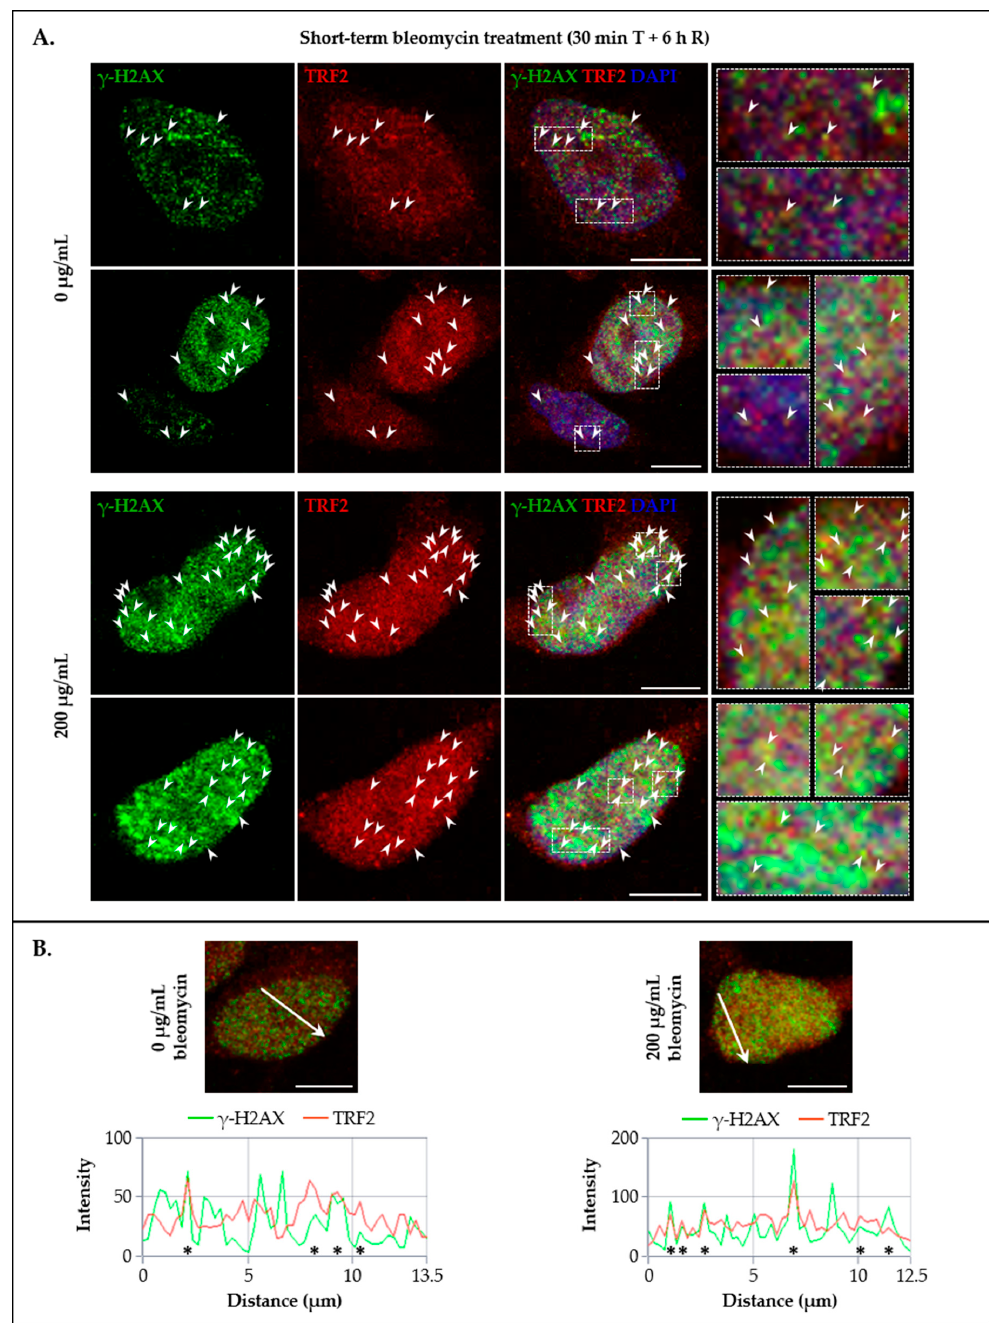
Figure 7. Analysis of the subcellular co-distribution of TRF2 and γ -H2AX in the human HeLa cell line. ( A ) Immunolocalization of γ -H2AX (green) and TRF2 (red) in control conditions and after DNA